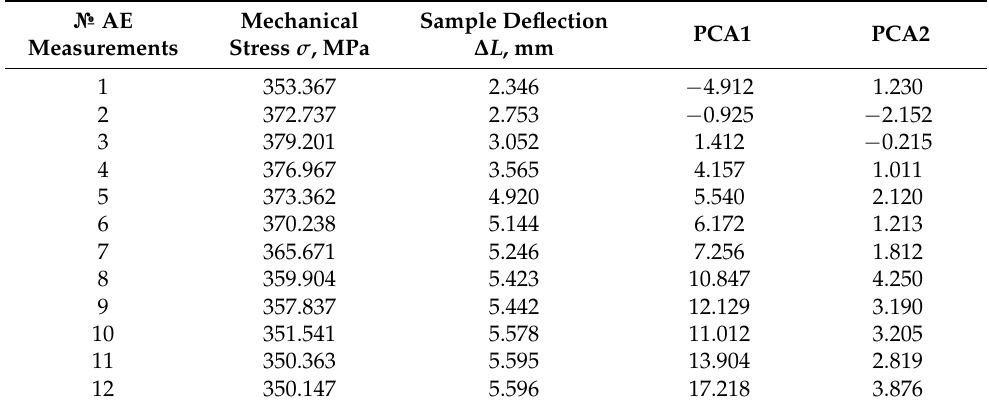
Table 3. Values of the first two principal components of PCA1 and PCA2 for four-point bending of specimens at the instants of successive fixation of AE signals.